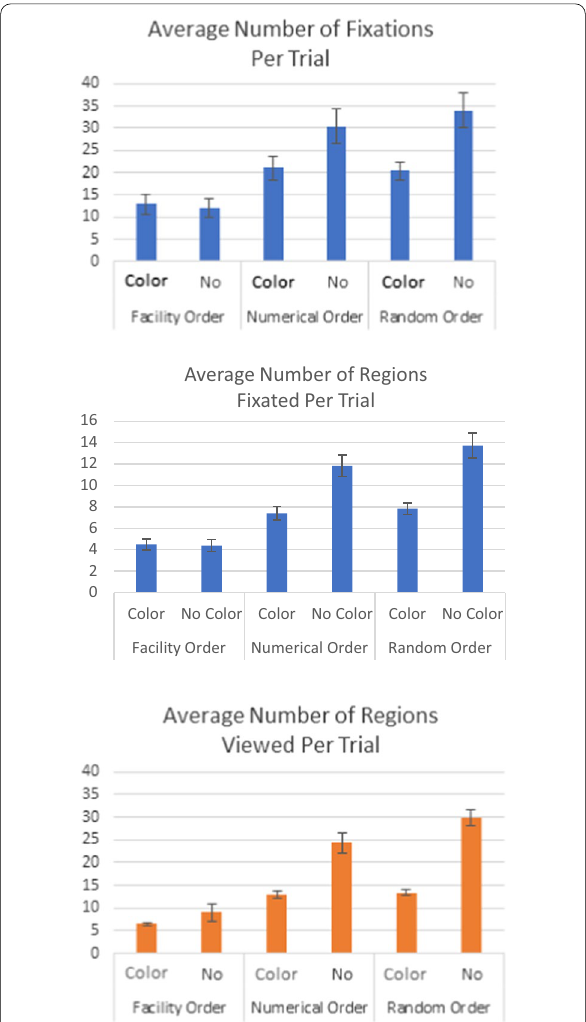
Fig. 6 The average number of fixations per trial for the eye tracking experiment (top), the average number of regions fixated per trial for the eye tracking experiment (middle), and the average number of regions viewed per trial for the artificial foveation experiment (bottom). Error bars show the standard error of the